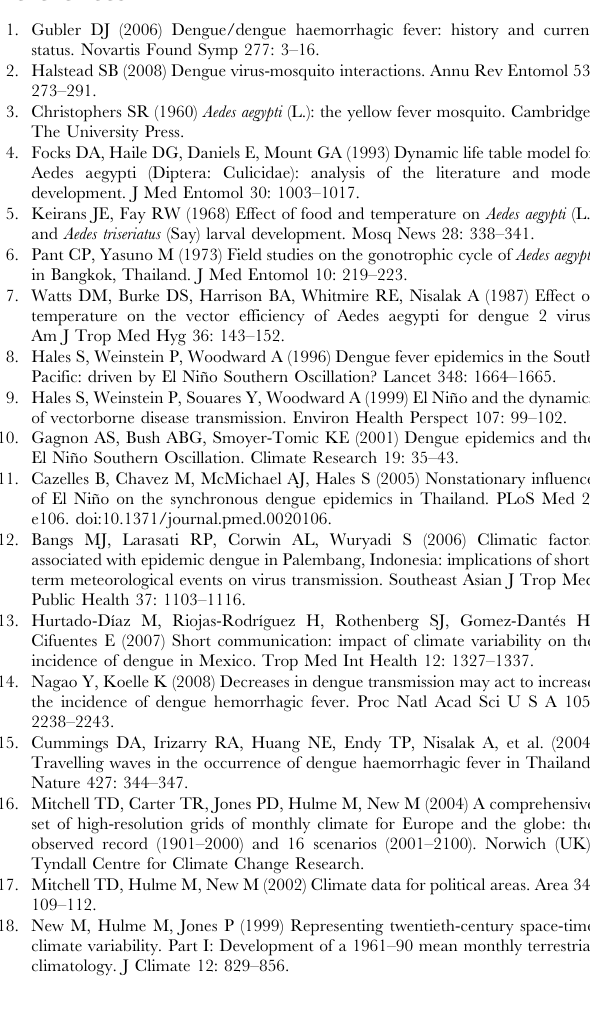
Figure S6 Coherence between precipitation and dengue in Puerto Rico between 1985 and 1991. (A) Phase of precipitation (solid black) and dengue incidence (red) and phase difference (dashed black) at a periodicity of 1.6–2 y. (B) Reconstructed precipitation (black) and dengue incidence (red) at a periodicity of 1.6–2 y.